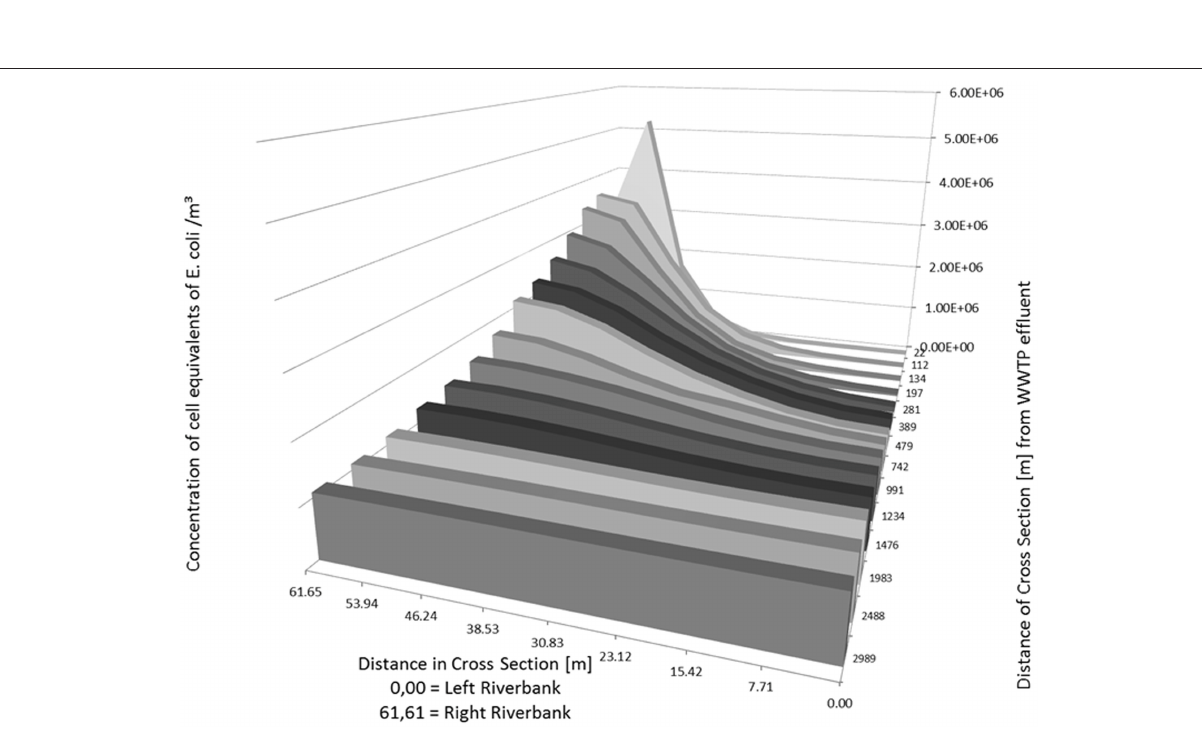
Frontiers in Microbiology | www.frontiersin.org